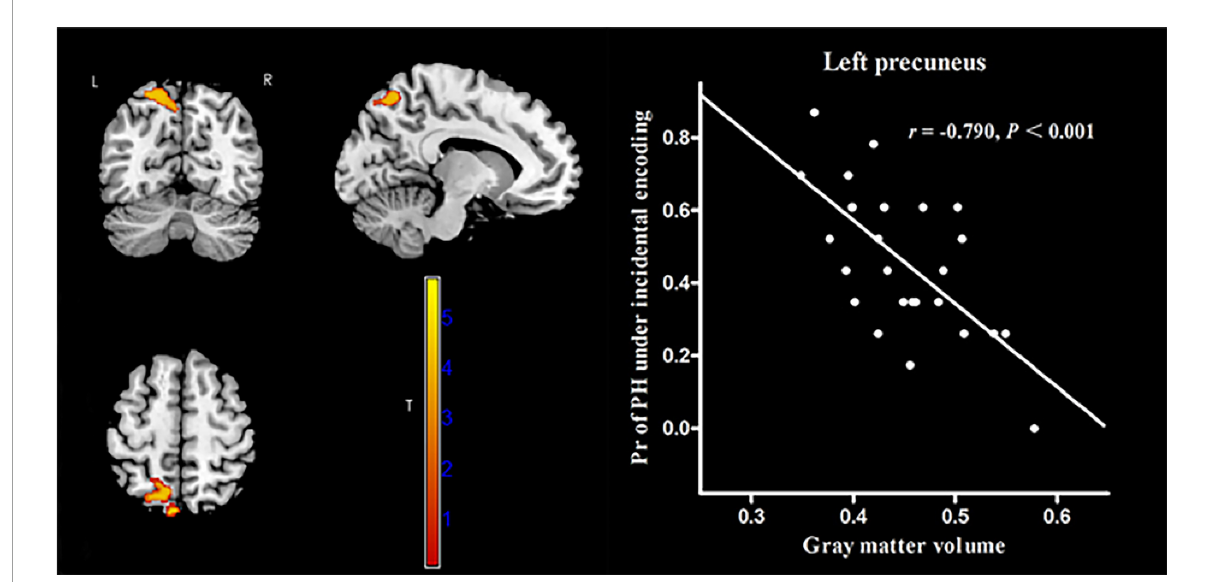
FIGURE4 Correlation between voxel-wise gray matter volume in the left precuneus and the Pr-PH (positive stimulus with high arousal) under incidental encoding in MWoA patients. p < 0.05, cluster-level FWE corrected. Scatter plot of ROI-based partial correlation analysis between gray matter volume in the left precuneus and the Pr-PH.